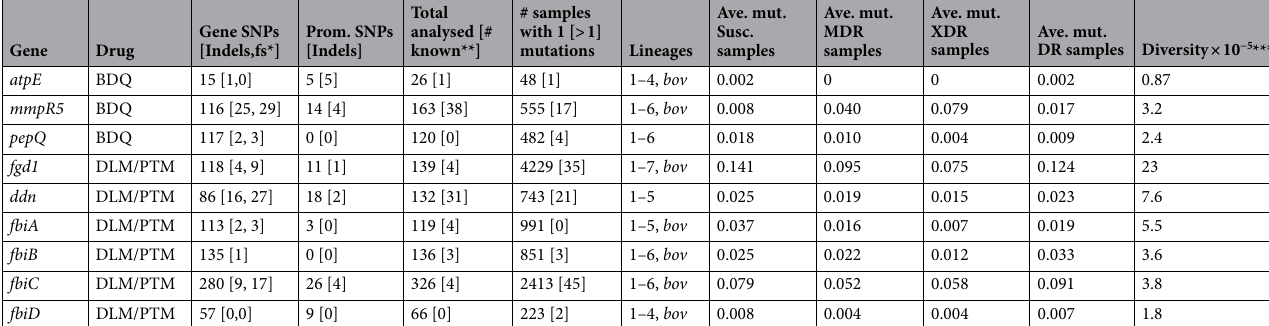
Table 1. Number of variants per analysed gene across the 33,675 isolates, with the average number of mutations per sample and by resistance profile. Indels = insertions and deletions; DLM = Delamanid; PTM = Pretomanid; BDQ = Bedaquiline; Prom. = promoter; Susc. = Susceptible; DR = Other drug resistance; fs = frame shifts; bov = M. bovis ; * number of indels that lead to frameshifts; ** see S3 Table; *** Nei’s Pi nucleotide diversity per site (only non-synonymous SNPs